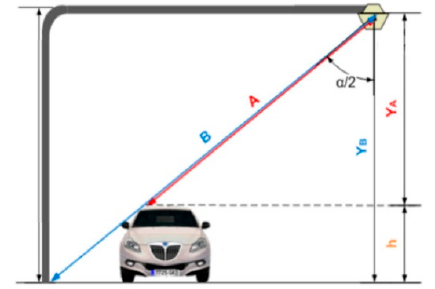
Figure 5. Height Figure 5. Height measurement. Figure 5. Height measurement.